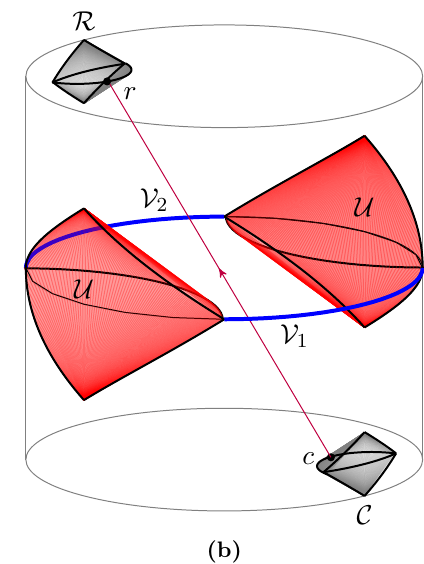
Figure 1. (a) An example arrangement of regions considered in the privacy-duality theorem. We’ve taken a case where regions U consists of two connected components. V and V are defined as in 1 2 theorem 1. Notice that all causal curves from c to r pass through U . (b) The same arrangement of regions shown in the bulk. There is a causal curve Γ which passes from c ∈ E to r ∈ E without P C R ever passing through the entanglement wedge of U . This allows a secret message to travel from C to R without an eavesdropper, who has access to U , being able to read it. The privacy-duality theorem gives that for the message to travel from C to R securely in the boundary picture, we must have I ( V : V ) = O (1 /G ) 1 2 | U N